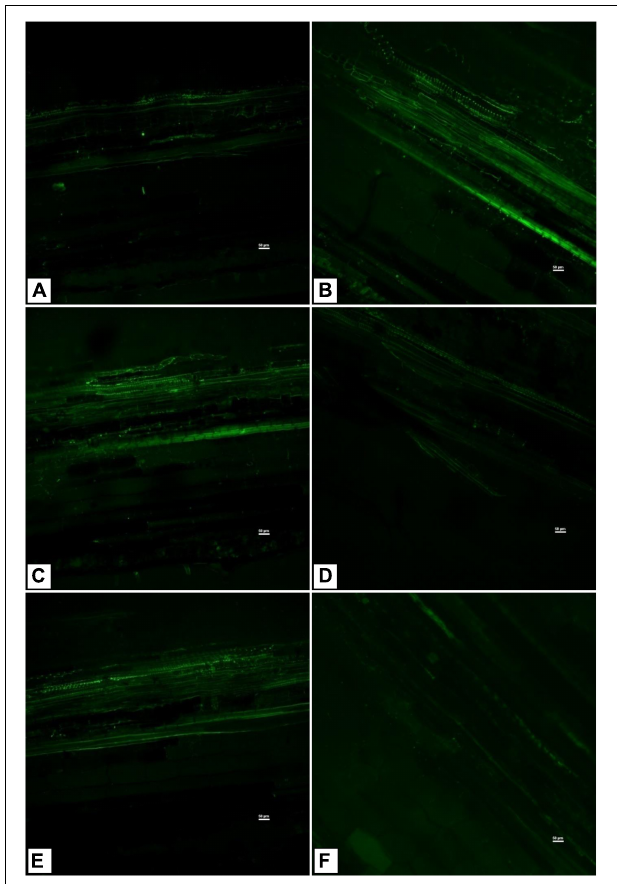
FIGURE 6 | Confocal scanning laser microscopy images showing radial Na + transport in shoot tissues stained with light-excitable Na + indicator Sodium Green TM Tetra (Tetramethylammonium) Salt. (A) Absolute control, (B) saline control, (C) BTL5, (D) GTR8, (E) GTR11, and (F) GTS16.